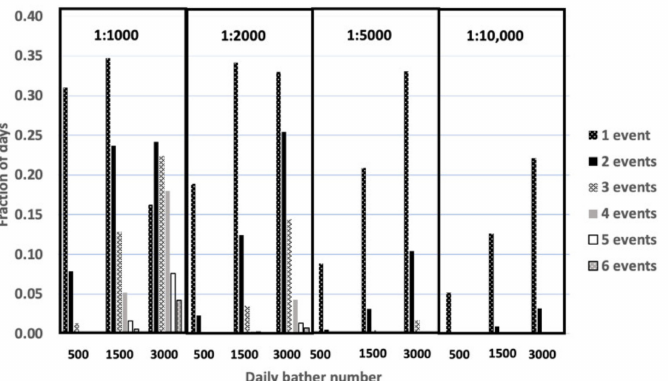
Figure 3. Monte Carlo analysis of the predicted impact of daily bather number (n = 500, 1500 or 3000) and the probability of a bather shedding a detectable number of oocysts (N = 1 in 1000, 1 in 2000, 1 in 5000 or 1 in 10,000) on the number of Cryptosporidium contamination events expected in a single day (expressed as the fraction of days predicted to have one to six events).